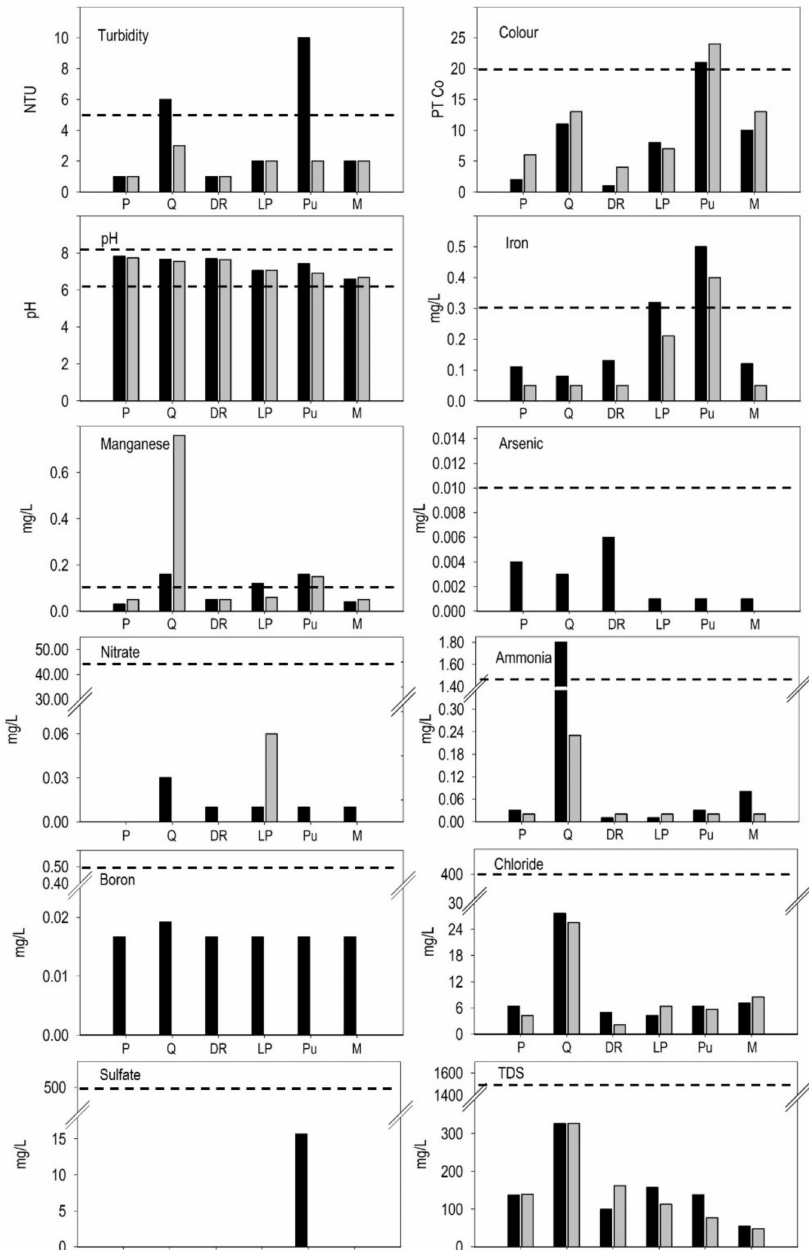
Figure 2. Results for treated water for each organization and its permissible limits according to the national standard except for boron, where the WHO guideline is used. The black and grey bars reflect the values found for the summer and winter samples, respectively. Only two organizations have out-of-range samples. P, Q, DR, LP, Pu and M stand for Pichil, Quilacahu í n, Desagüe Rupanco, La Picada, Puaucho and Maicolpue,